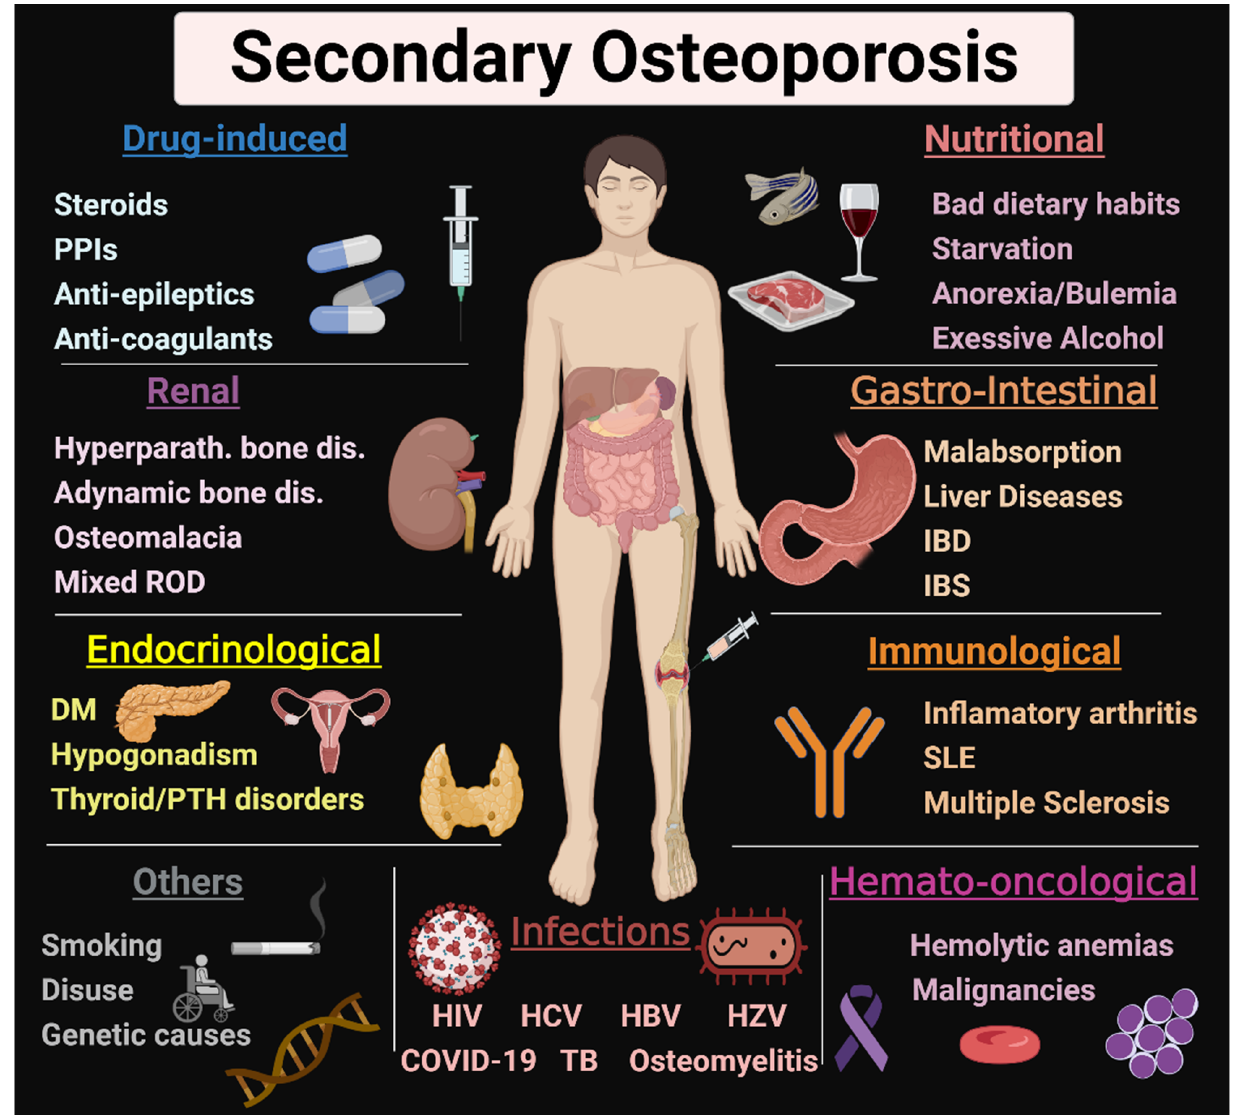
Figure 1. Causes of secondary osteoporosis. Various causes of secondary osteoporosis are illustrated in this figure. They include ROD, DM, thyroid and parathyroid disorders, malabsorption, IBD, IBS, nutritional causes, drug-induced, infections, anemia, malignancies, inflammatory arthritis, SLE, smoking, and genetic causes. PPIs: proton pump inhibitors, ROD: renal osteodystrophy, DM: diabetes mellitus, PTH: parathyroid, IBD: inflammatory bowel disease, IBS: irritable bowel syndrome, SLE: systemic lupus erythematosus. HIV: human immunodeficiency virus, HCV: hepatitis C virus,